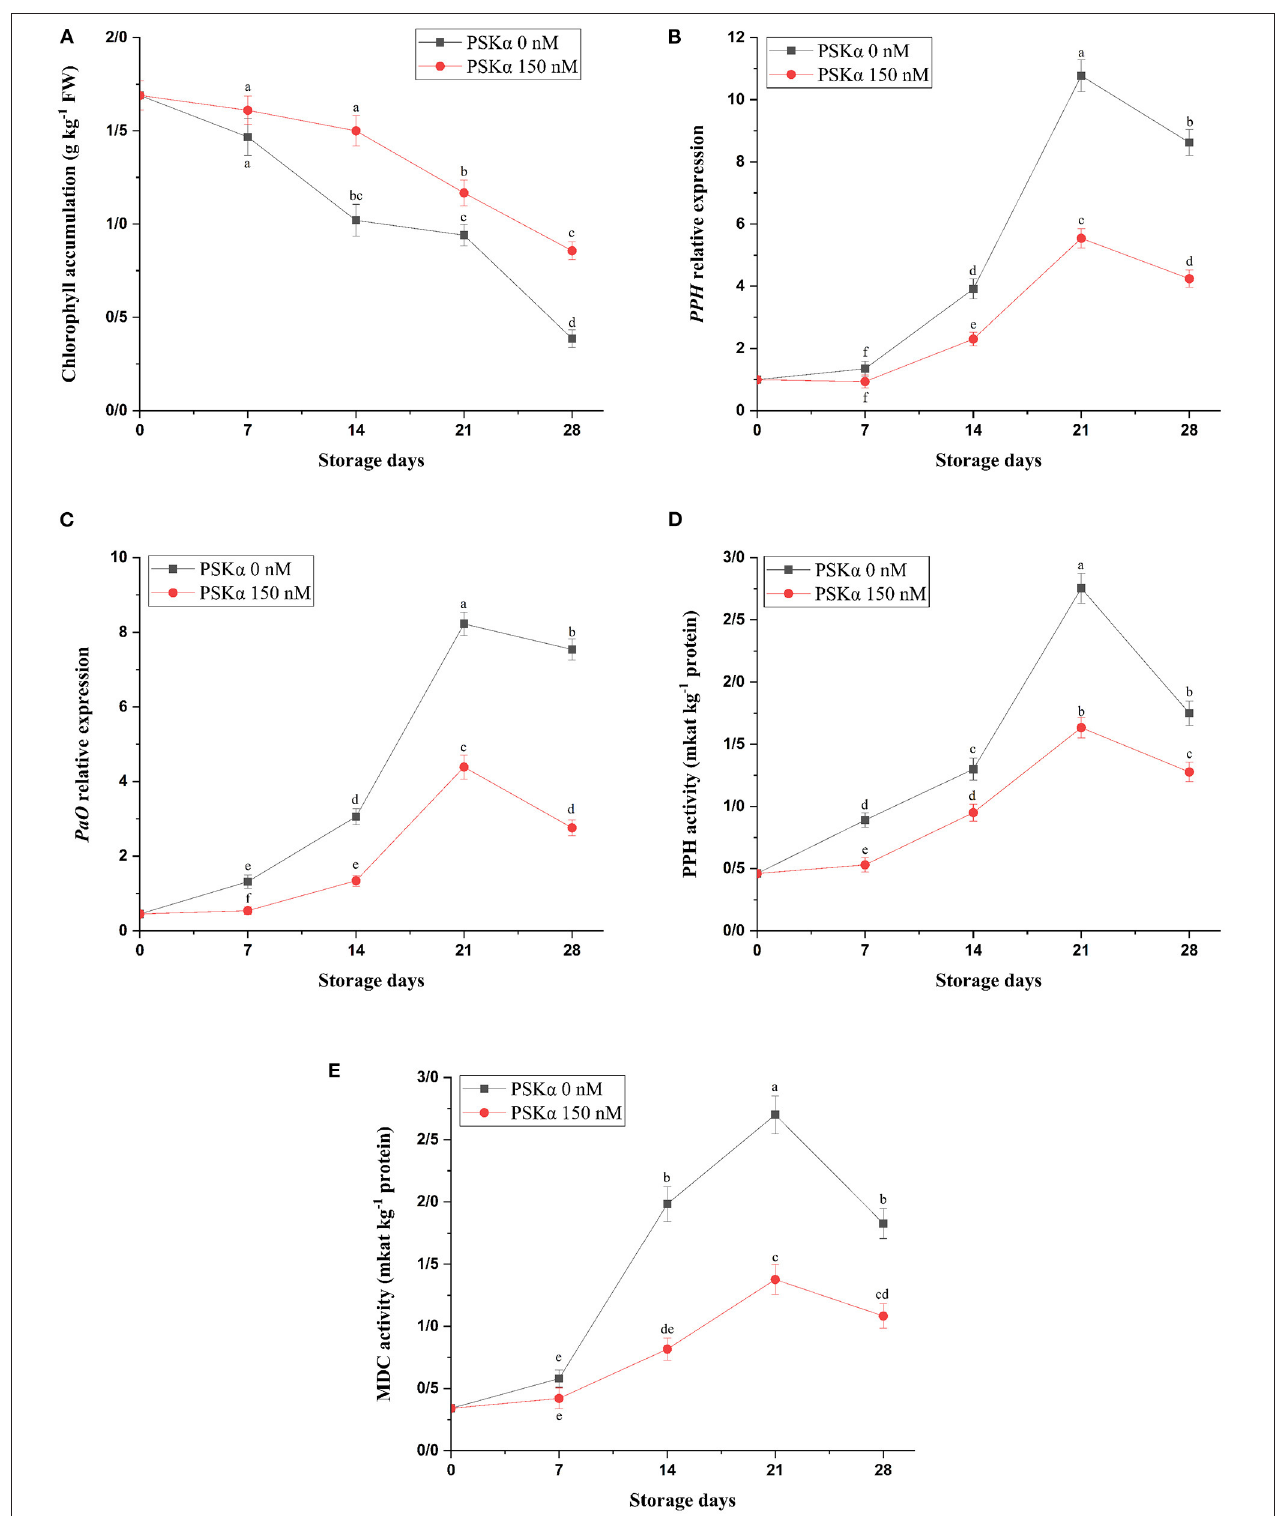
FIGURE 2 | Chlorophyll accumulation (A) accompanied by PPH and PAO gene expressions (B,C) and MDC and PPH enzyme activities (D,E) in broccoli floret treated with PSK α at 0 and 150nM during storage at 4 ◦ C for 28 days. Data shown are mean values of n = 3, and the error bars represent standard errors of the means. Tukey’s test at P = 0.05